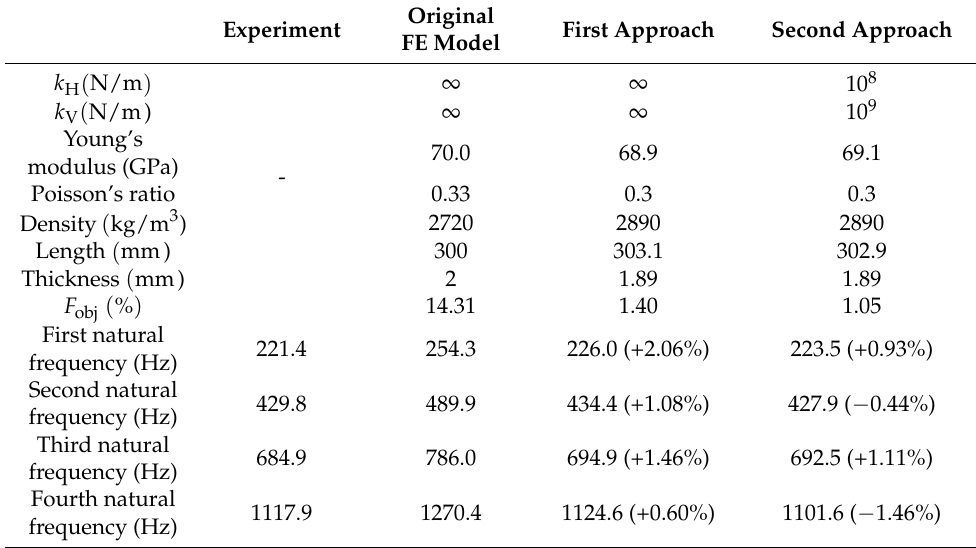
Table 11. Optimal results and updated parameters.